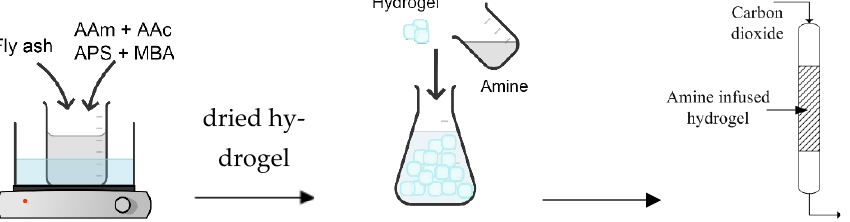
Figure 10. Illustration of synthesis and CO 2 adsorption of MEA infused FA-AAc/AAm hydrogel adsorbent.